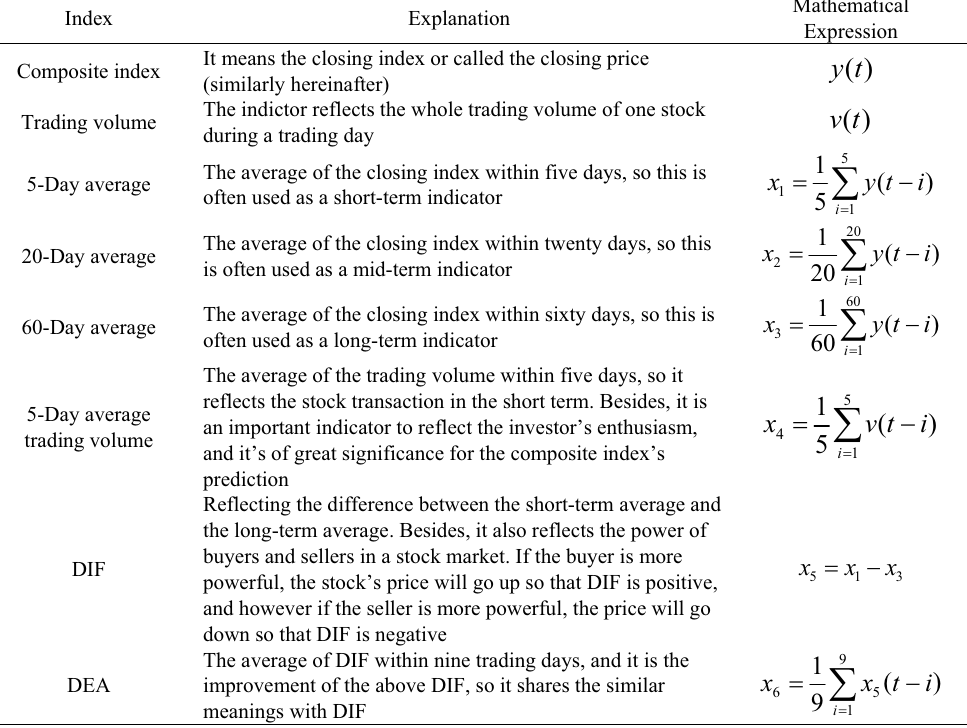
Table 1. The widespread indicators used for the technical